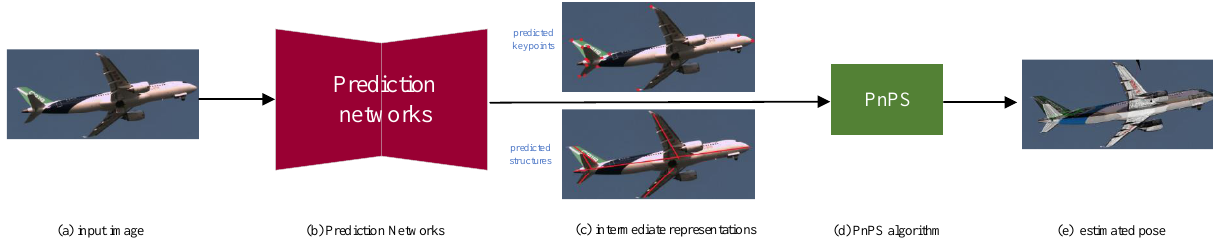
Figure 4. Pipeline of our approach. Given a single RGB image of an aircraft ( a ), we utilize prediction networks ( b ) to locate the keypoints (red points) and structures (red structures) which serve as intermediate representation ( c ). Then the 6D pose is estimated by the PnPS algorithm ( d ) based on the predicted results ( e